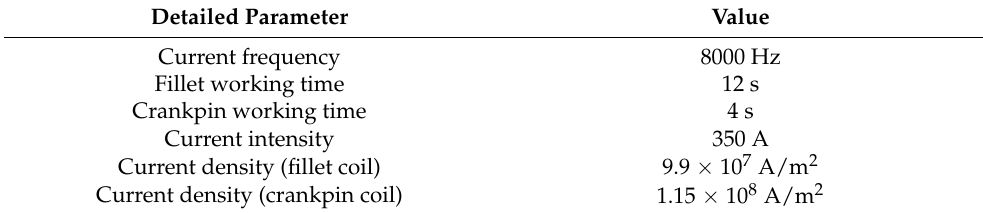
Table 2. Parameters of the load. Detailed